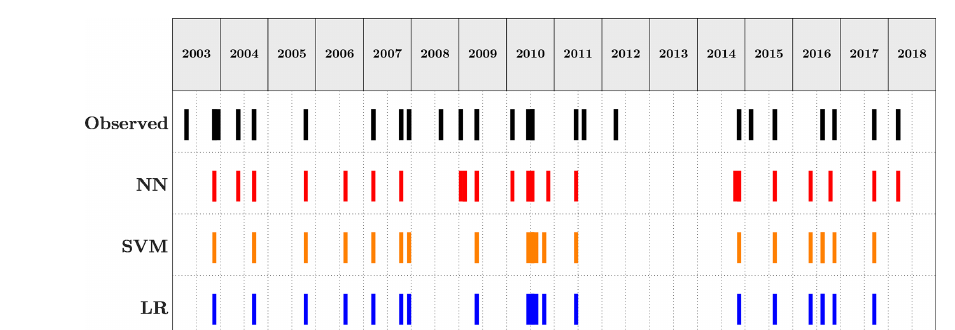
Figure 8. Comparison of the predictions of the three methods over the testing set vs. the observed events. Flood